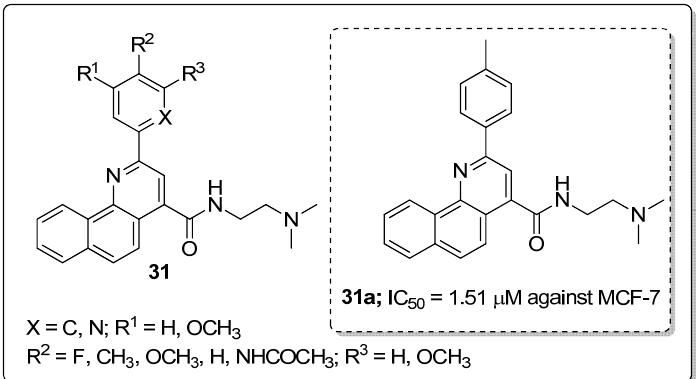
Figure 36. Antiproliferative activity of most active tetrahydrobenzo ‐ quinoline scaffold 31a .